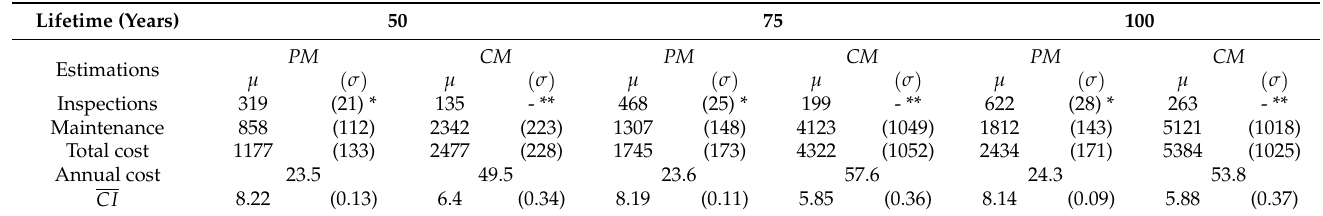
Figure 5. One realisation of the PM compared to one realisation of the CM . (cid:0) € (cid:1) Table 5. Costs /m 2 and average condition index for the PM and CM maintenance